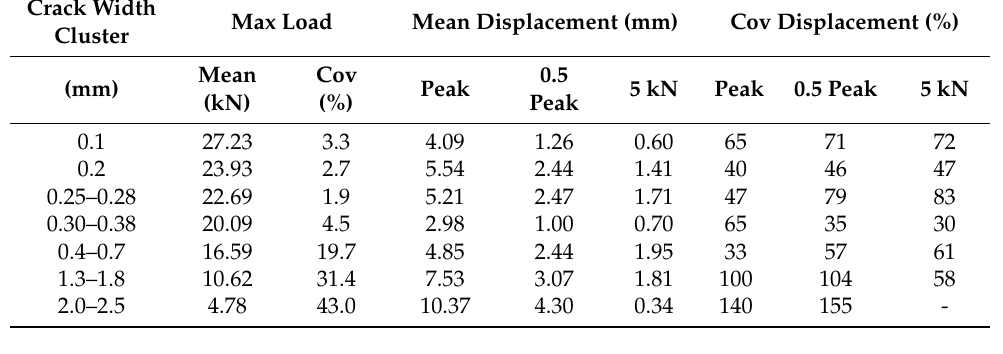
Figure 10. Load vs. crack width (all results and up to 0.7 mm).